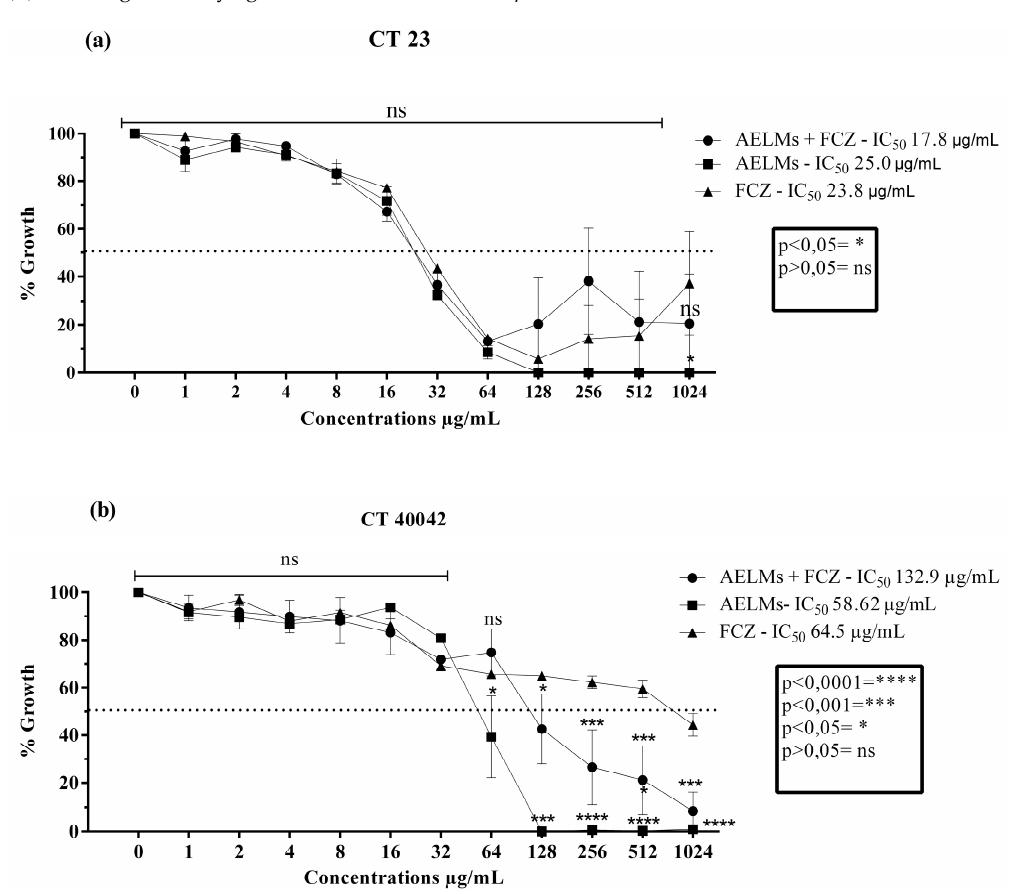
Figure 5. Cell viability curve and IC 50 values (concentration responsible for 50% colony growth inhibition) of the Mesosphaerum suaveolens aqueous aerial parts extract (AEAPMs) and fluconazole (FCZ) in µg/mL against Candida tropicalis . ( a ) Antifungal activity against strains of Candida tropicalis LM 23. ( b ) Antifungal activity against strains of Candida tropicalis INCQS 40042.